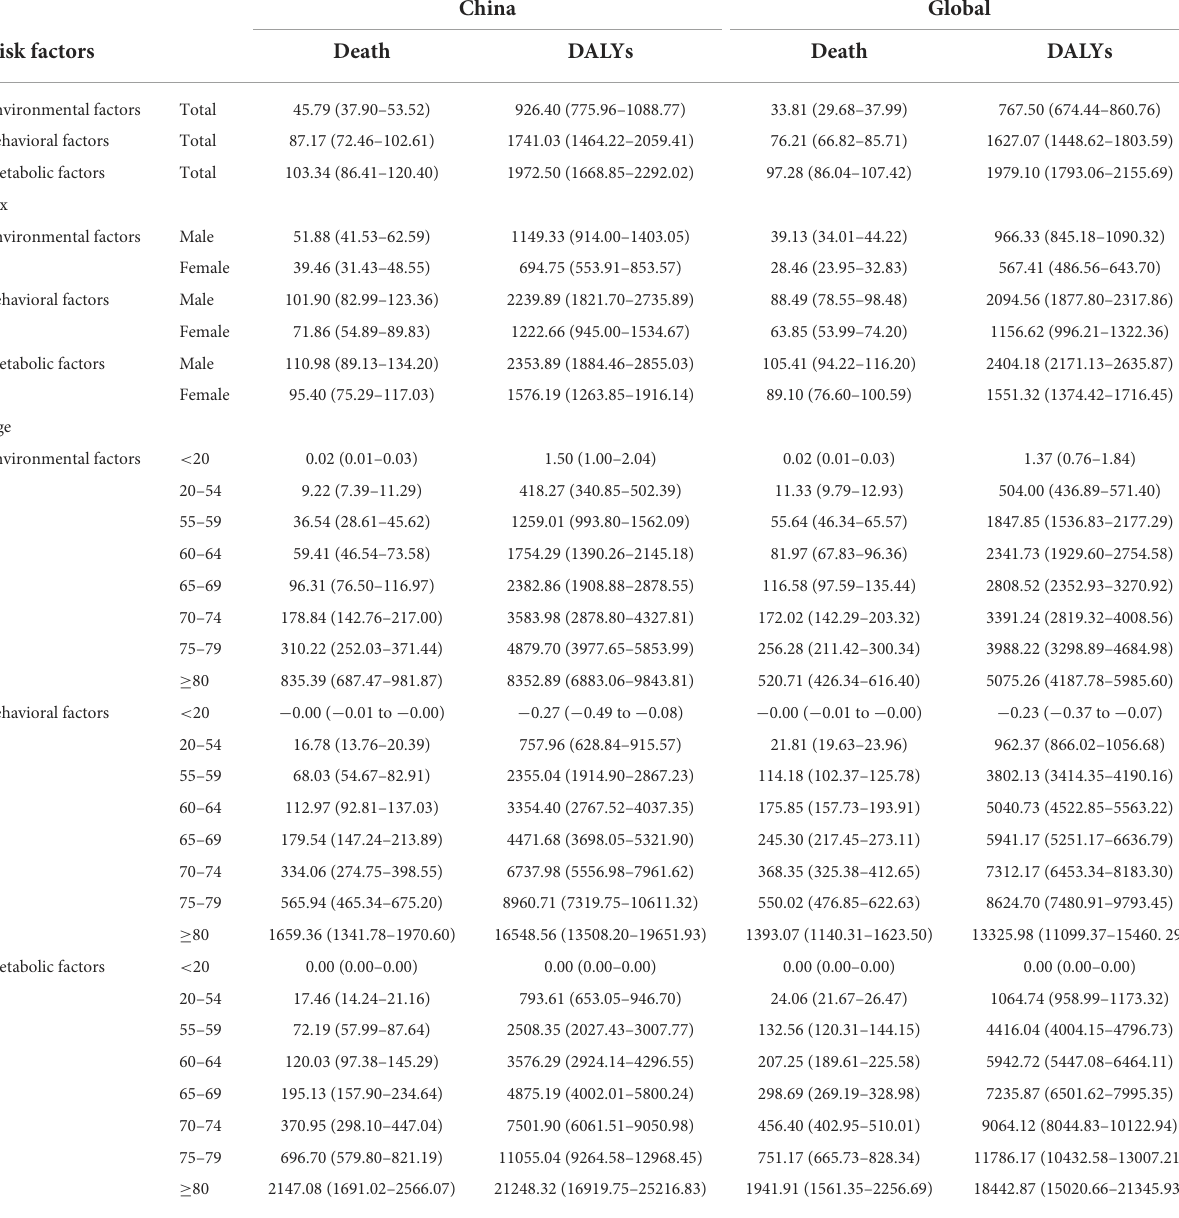
TABLE 3 Death rate and DALYs of risk factor-related IHD in China and worldwide in 2019